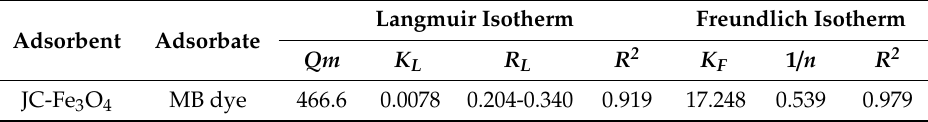
Table 1. Adsorption isotherm parameters for MB dye onto JC-Fe 3 O 4 adsorbents. Adsorbent